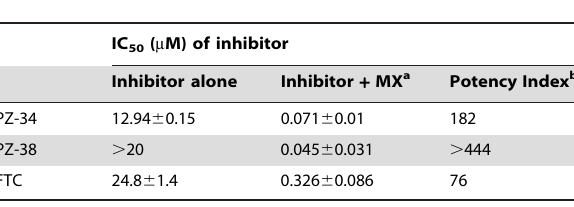
Table 1. Potency index of PZ-34 and PZ-38 for sensitization of mitoxantrone resistance in HEK293/ABCG2 cells.